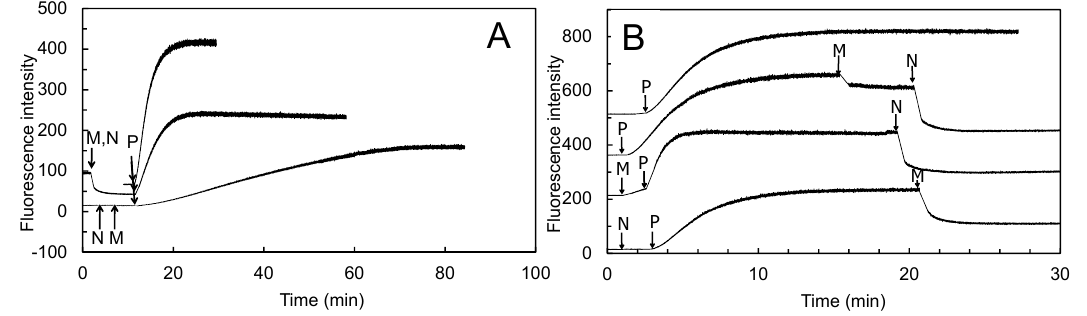
Figure 13. Effect of human MICAL-MO on actin polymerization state as determined fluorimetrically. ( A ) The polymerization state of pyrene-labelled G-actin (4.1 µM) in the presence or absence of NADPH (100 µM, N) and human MICAL-MO (660 nM, M) was monitored fluorimetrically in a Cary Eclipse (Varian) fluorimeter. The polymerization was induced by addition of 1/10 volume of polymerization buffer (P, 50 mM Tris/HCl, pH 7.5, , 5 mM DTT, 10 mM ATP) at the indicated time to the 500 mM KCl, 20 mM MgCl 2 solution in G-buffer (5 mM Tris/HCl, pH 8.0, 0.2 mM CaCl , 0.2 mM ATP, 1 mM DTT); 2 ( B ) Fluorescence-monitored polymerization and depolymerization of actin (2.3 µM) in the presence of NADPH (100 µM, N) and human MICAL-MO (660 nM, M) added at the indicated times. In the panels the traces have been offset for graphical purposes. Reprinted from [70] with permission from